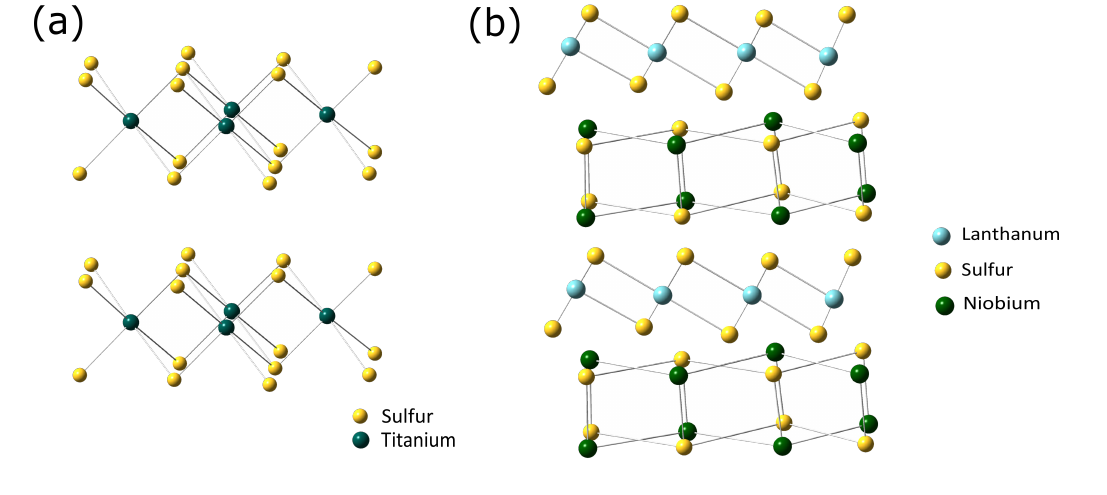
Figure 7: Crystal structures of (a) TiS 2 and (b) [LaS] 1.14 NbS 2